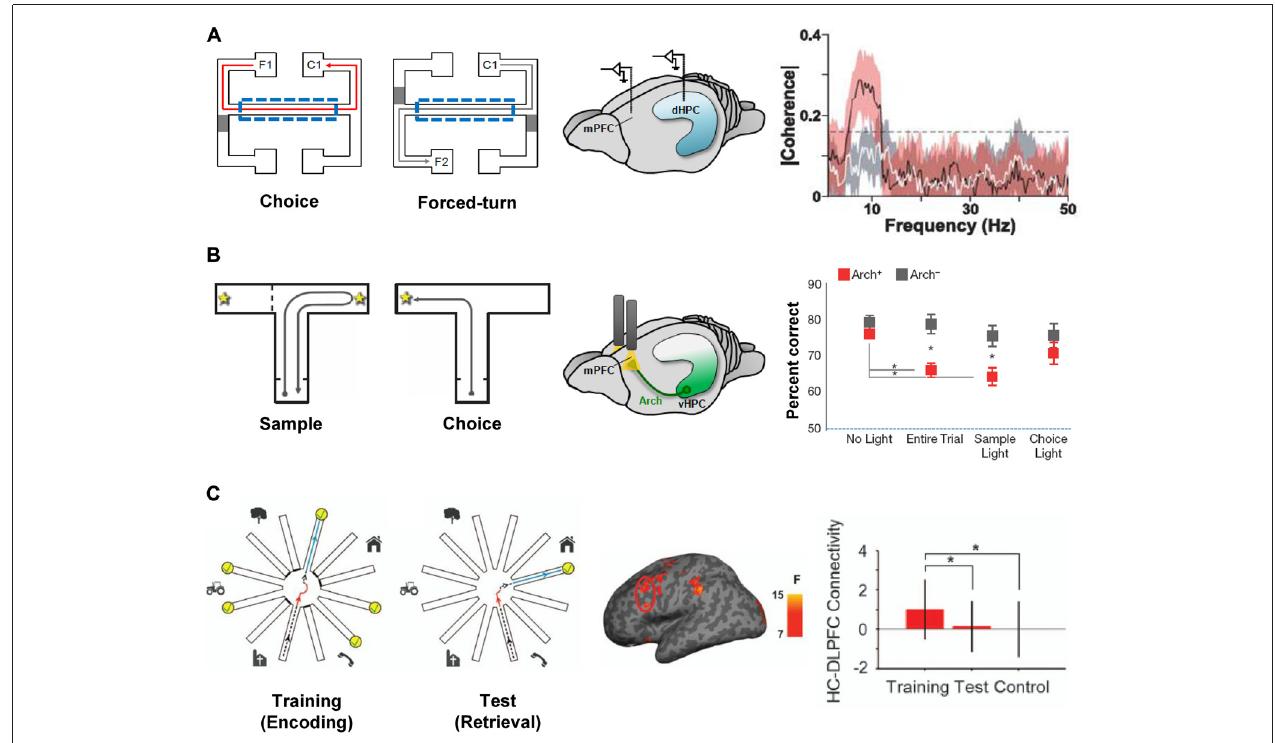
FIGURE 2 | Hippocampal-prefrontal interactions during spatial working memory (SWM). (A) Hippocampal-prefrontal synchrony during a SWM task. Left: during “choice” trials, rats had to choose the arm on the same side as the one they left from (i.e., C1 when leaving from F1) whereas during “forced-turn” trials animals were directed to enter one arm by closing off the other with a barrier. Working memory is therefore required in the center arm (dashed line) during choice trials but not forced-turn trials. Simultaneous recordings from the dHPC and mPFC (middle) revealed stronger theta coherence between the two structures during center arm runs in choice compared to forced-run trials (right). Adapted from Jones and Wilson (2005a). (B) Silencing ventral hippocampal inputs to the PFC impairs SWM performance. Left: mice performed a SWM task where, in the “choice” phase, they had to choose the arm opposite to the one visited in the “sample” phase. During task performance, ventral hippocampal inputs to the PFC were optogenetically silenced with light (middle) during different task phases. Performance in the choice phase was only impaired when silencing was performed during the entire trial or in the sample phase (right). Adapted from Spellman et al. (2015). (C) Hippocampal-prefrontal functional connectivity in human subjects during a virtual reality SWM task. Left: during the “training” phase subjects navigated a virtual reality version of the radial arm maze and had to collect reward from six arms (yellow) while the other six were closed. During the “test” phase subjects had to enter the previously closed arms to collect reward. Functional connectivity measured between the dorsolateral PFC and hippocampus (middle) was strongest during the training phase (right). Adapted from Bähner et al.